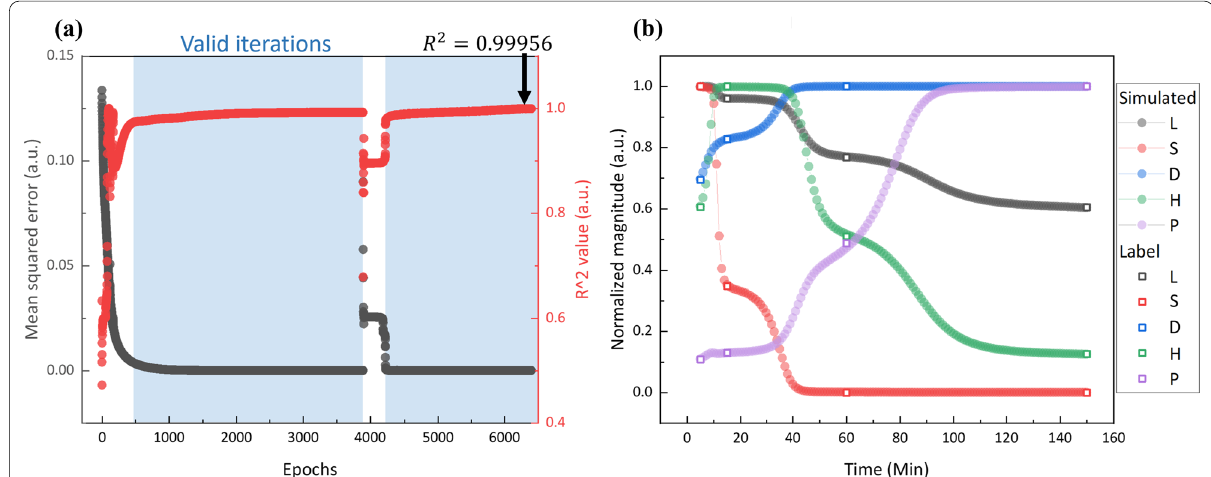
Fig. 3 a Parameter training result. As mean squared error decreases, the R 2 value of the fitting between latent variable and annealing time increases. Maximum R 2 value of 0.99956 is acquired at epoch 6318, from which subsequent reconstruction training has been followed. Mean squared error less than 0.005 is considered valid. b Simulated parameters after the initial parameter training, with selection of maximum R 2 value. Five parameters are simulated based on the labels at four different times: 5, 15, 60, and 150